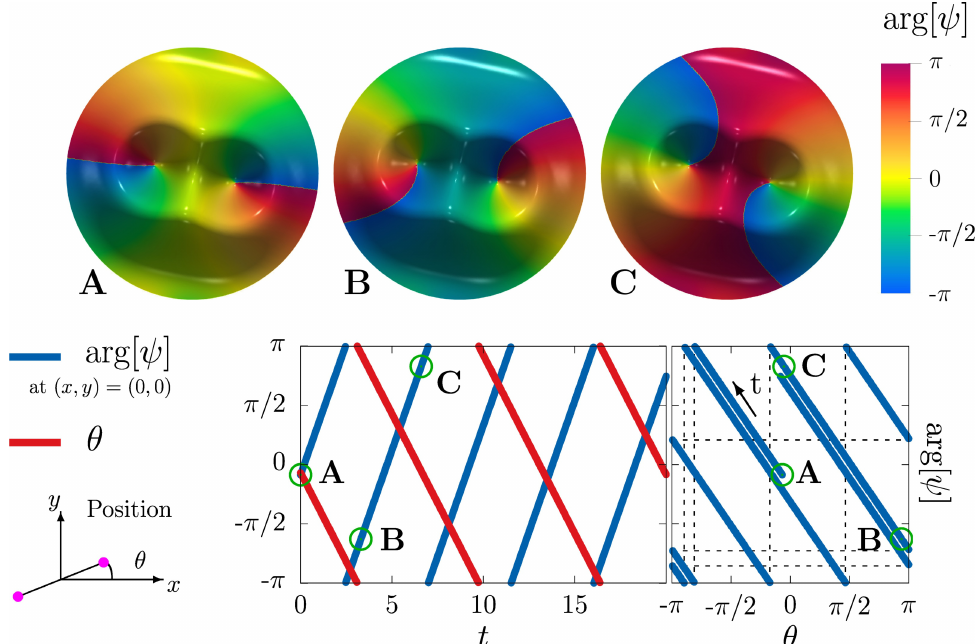
Figure 3 . The evolution of a minimum energy configuration ψ min ( x ) , in the case of a symmetric vortex pair (with g = 5 ) in region D of figure 2. The bottom panels show the evolution of θ , the rotation angle of the pair, and of the value of the phase arg[ ψ ] measured at the center of the trap. The three panels A–C on the top row are snapshots displaying the phase arg[ ψ ] after rotations θ = θ 0 , θ = θ 0 + π and θ = θ 0 + 2 π respectively. Since the Lagrange multipliers λ min not commensurate, arg[ ψ ]( t ) and θ ( t ) feature different periodicities. As a result after π rotations of the pair the phase profile is not simply an overall phase